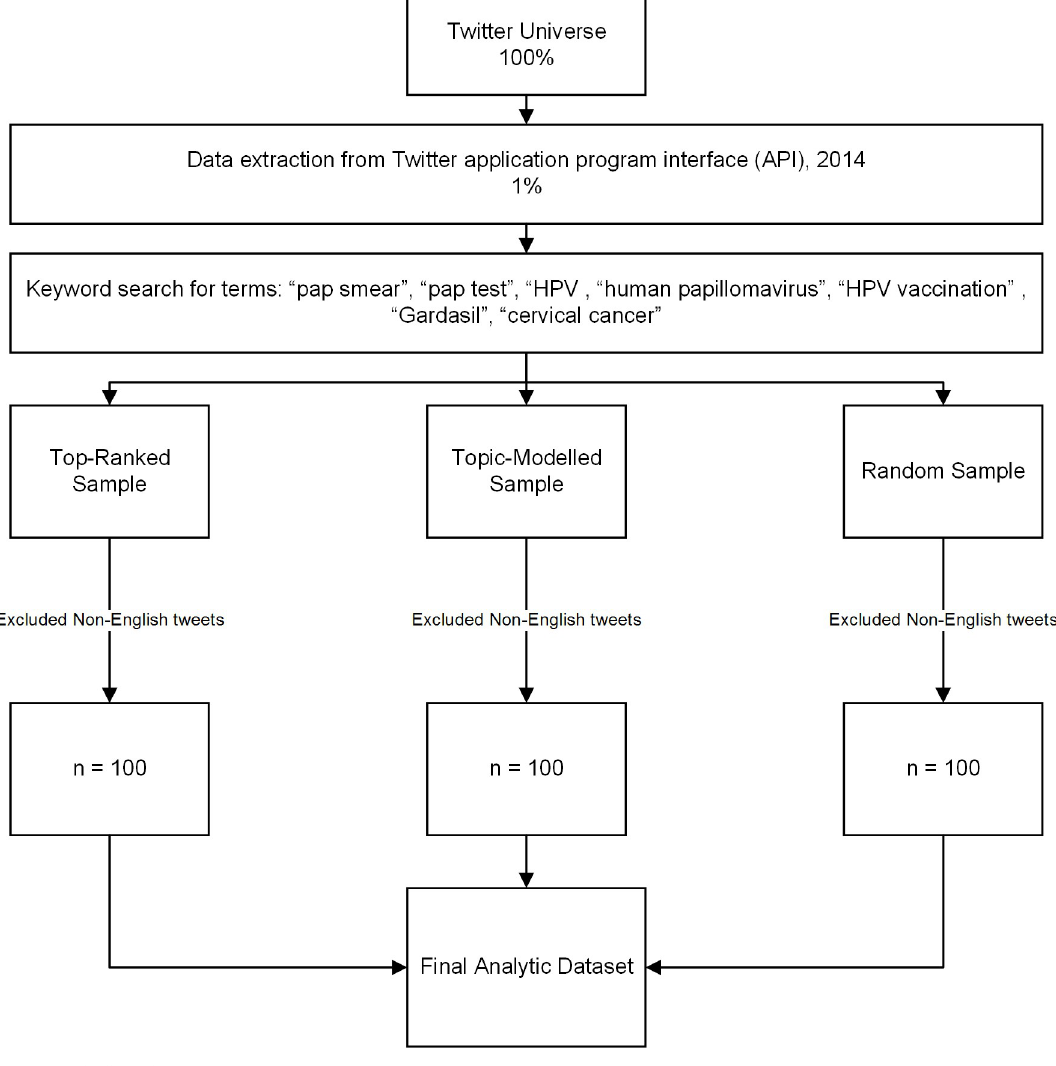
Fig 1. Study flow